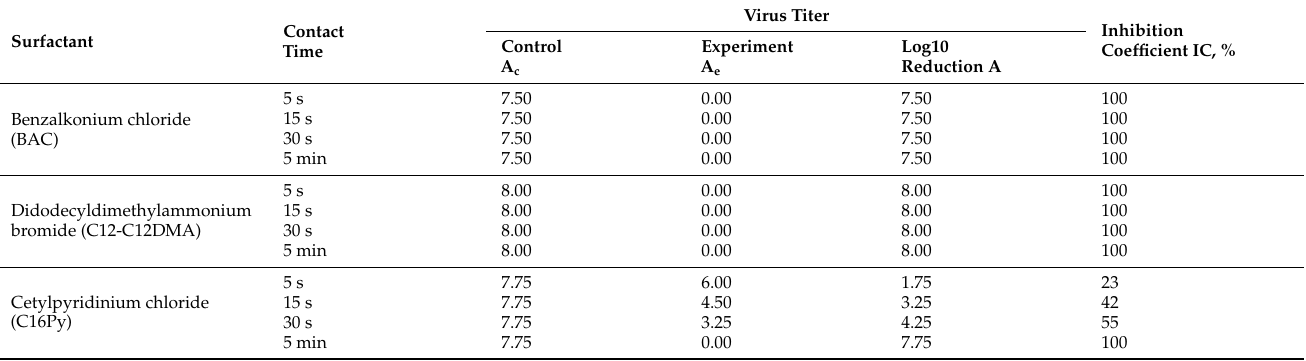
Table 3. SARS-CoV-2 inactivation by 2.8 mM cationic surfactants at different virus-disinfectant contact